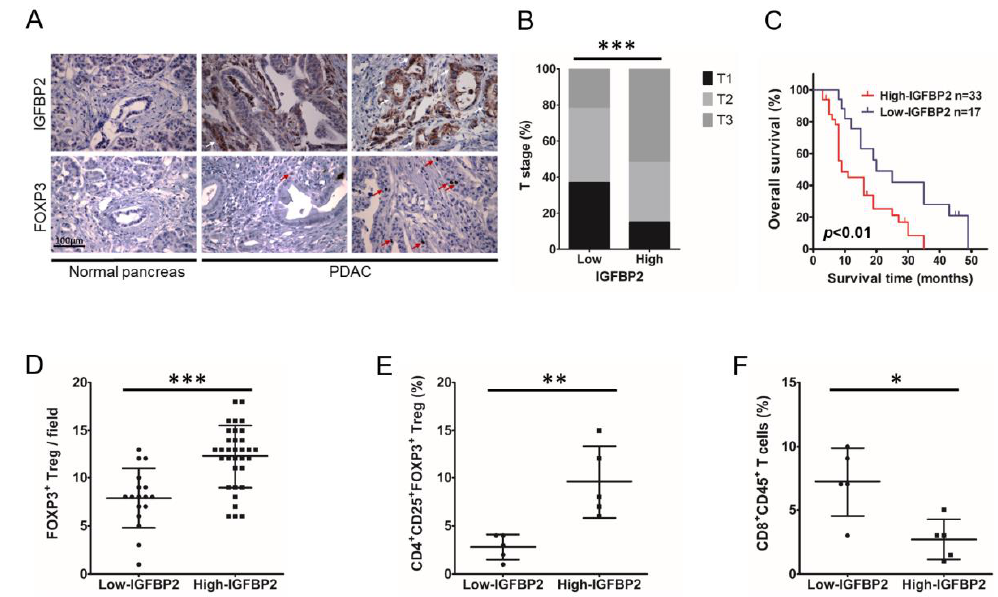
Figure 1. IGFBP2 overexpression is associated with Treg infiltration in the tumor microenvironment and disease progression in human PDAC. ( A ) IGFBP2 and FOXP3 amounts in PDAC and noncan- cerous pancreatic tissue specimens. Magnification: 400×. White arrows point to IGFBP2 + PDAC cells; red arrows point to FOXP3 + cells as Tregs. ( B ) Distributions of T stage in the high- and low-IGFBP2 expression groups ( n = 50; *** p < 0.001 by χ 2 test). ( C ) Kaplan – Meier curves comparing overall sur- vival rates in PDAC cases with high and low IGFBP2 levels ( n = 50; p < 0.01 by log-rank test). ( D ) Counts of FOXP3 + cells as Tregs in the PDAC microenvironment with reduced and elevated IGFBP2 amounts ( n = 50; *** p < 0.001 by the Student’s t -test). ( E ) CD4 + CD25 + FOXP3 + cells (Tregs) assessed flow-cytometrically in PDAC tissue samples from freshly collected surgical specimens with reduced and elevated IGFBP2 amounts ( n = 10; ** p < 0.01 by the Student’s t -test). ( F ) CD8 + CD45 + T cells assessed flow-cytometrically in the latter PDAC tissue specimens ( n = 10; * p < 0.05 by the Stu dent’s t -test). Data are mean ± SD from 3 or more assays performed independently. To explore the association of IGFBP2 expression with Treg infiltration in the human PDAC microenvironment, IHC was first performed to detect FOXP3 + T cells (red arrows point to FOXP3+ cells as Tregs) in the above 50 PDAC specimens. The results revealed PDAC highly expressing IGFBP2 had markedly larger amounts of Tregs compared with the low IGFBP2 group ( p < 0.001; Figure 1D). To validate the association of IGFBP2 with immune cell infiltration in PDAC, 10 freshly collected human PDAC specimens (5 low IGFBP2 and 5 high IGFBP2 cases determined by IHC based on non-cancerous specimens) were assessed flow-cytometrically for CD4 + CD25 + FOXP3 + (Tregs) and CD8 + CD45 + (cyto- toxic T cells). The high IGFBP2 group had markedly elevated percentages of Tregs ( p < 0.01; Figure 1E), corroborating the above IHC data in a larger population (Figure 1A). Ad- ditionally, cytotoxic T cell rates were starkly decreased in the high IGFBP2 group ( p < 0.05; Figure 1F). The above findings suggested elevated IGFBP2 amounts in PDAC were asso- ciated with increased infiltration of Tregs, suggesting an immunosuppressive TME and disease progression.